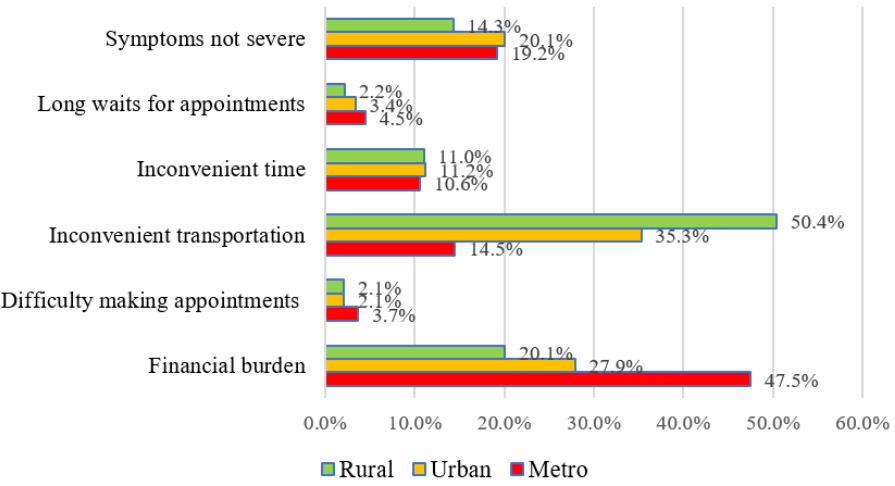
Figure 2. Reasons healthcare needs were not met according to residential area .